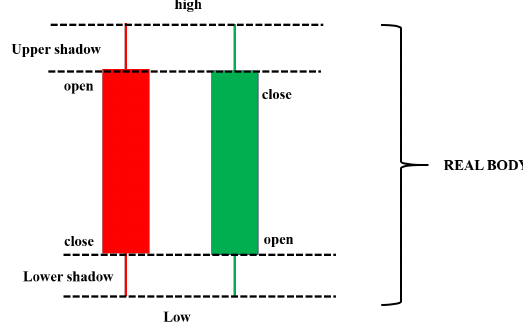
Figure 4. An example of a candlestick chart.